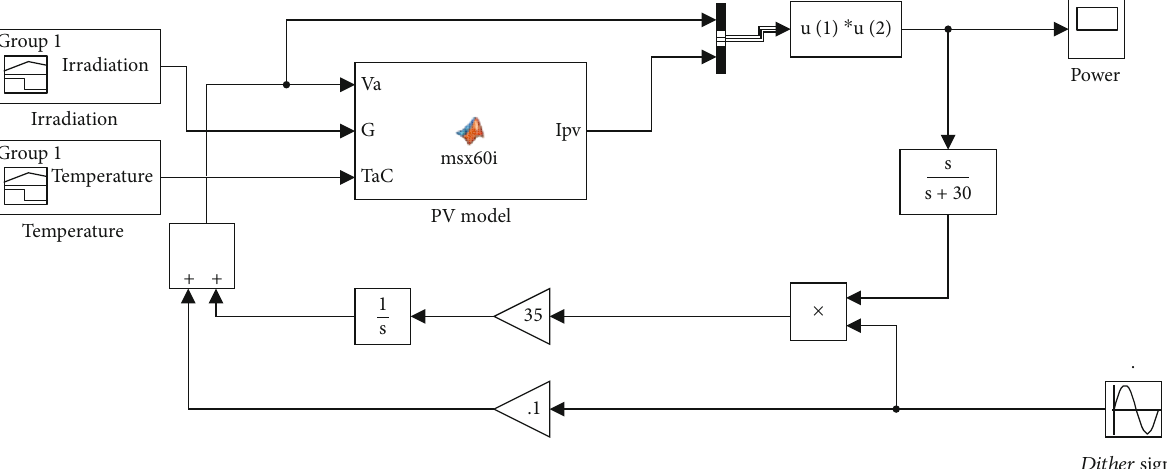
Figure 7: Simulink model of the conventional ESC algorithm.